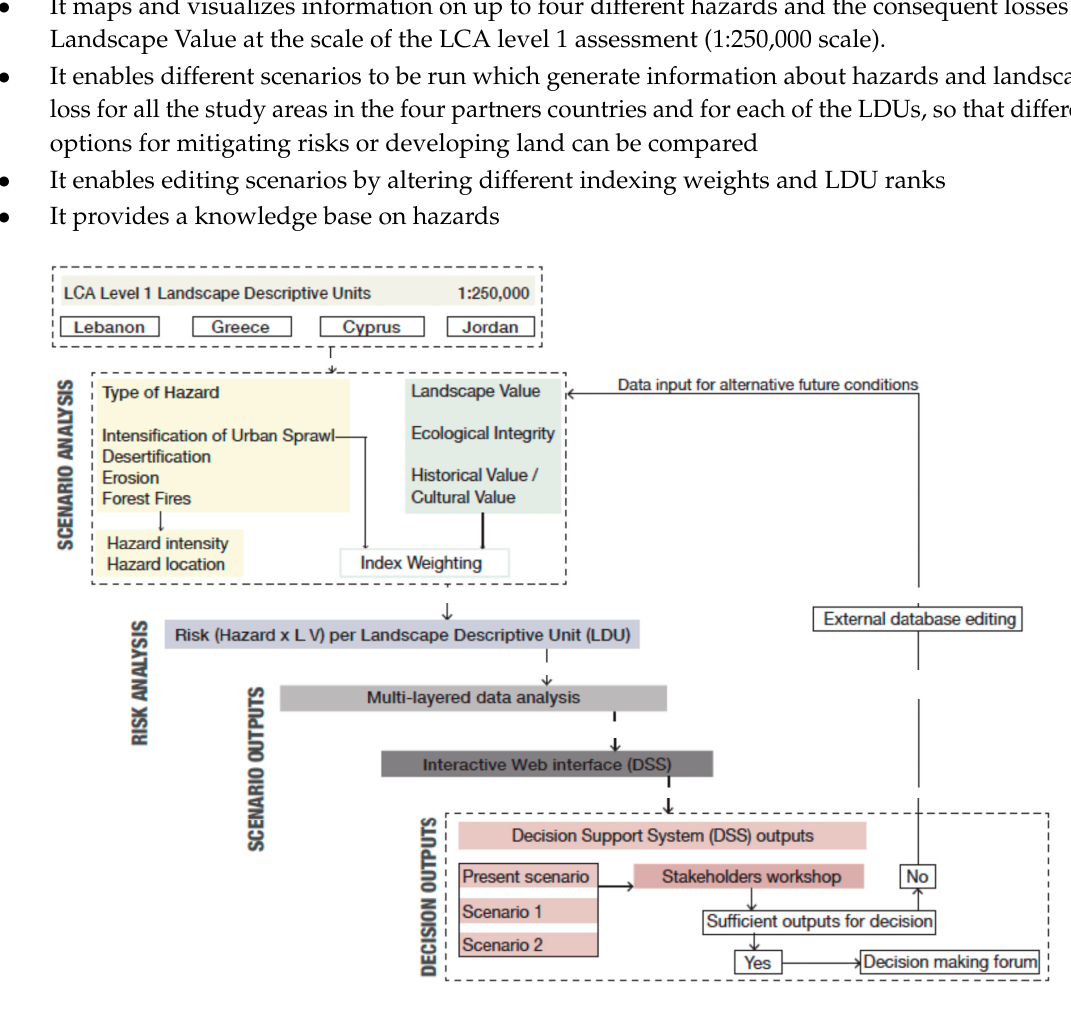
Figure 9. Methodology: from Risk Assessment to Decision Support System. LCA, Landscape Attribute; LV, Landscape Character Attribute; LV, Landscape Value.